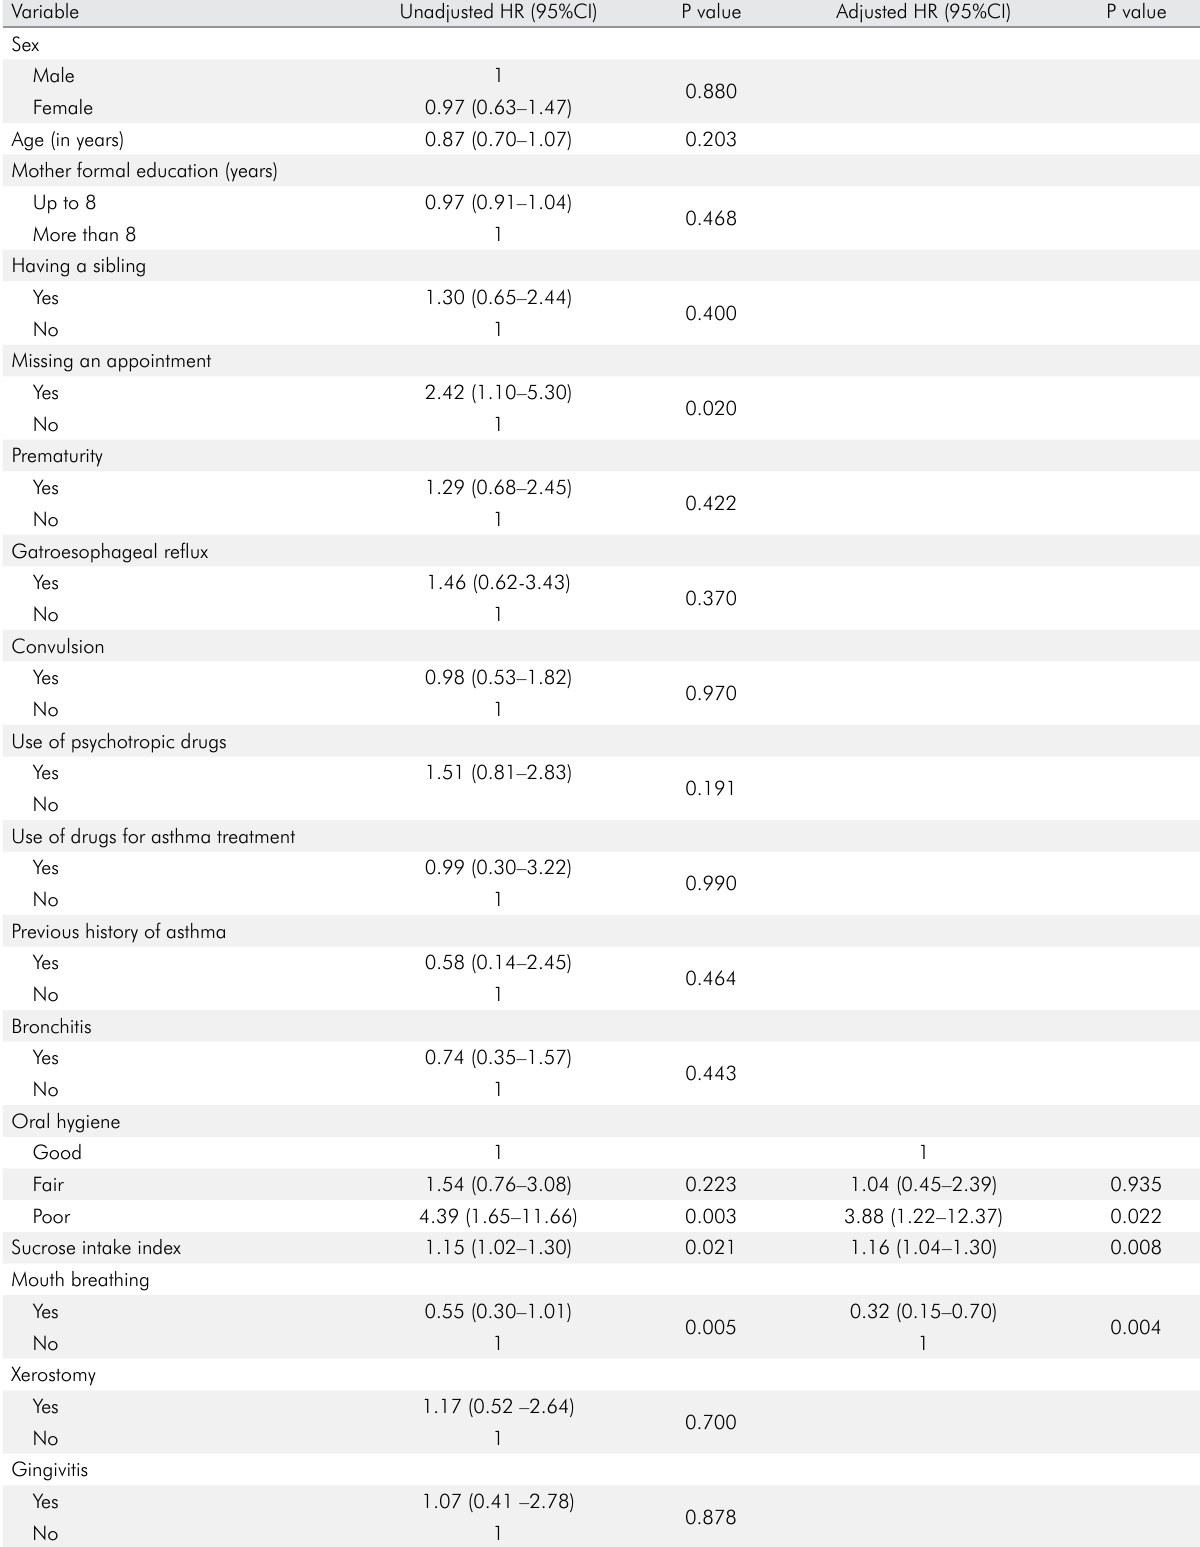
Table 2. Risk factors for new dental caries lesions among patients with developmental disabilities in Belo Horizonte, Brazil, from 1998 to